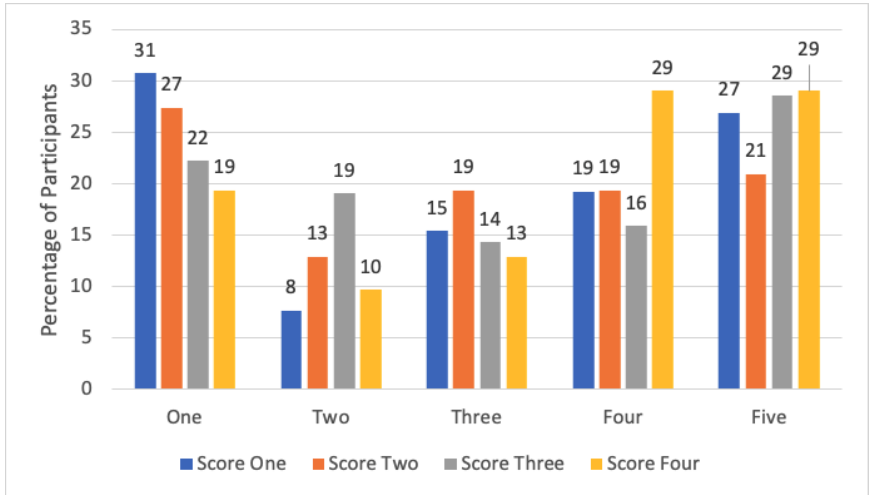
Figure 10. SONA survey: Likelihood of using the password “F63$uj2*” and password strength score. In this figure, the bar charts indicate the password score as measured by zxcvbn. The x-axis indicates how likely a participant says they are to use this password – 1 is “not likely” and 5 is